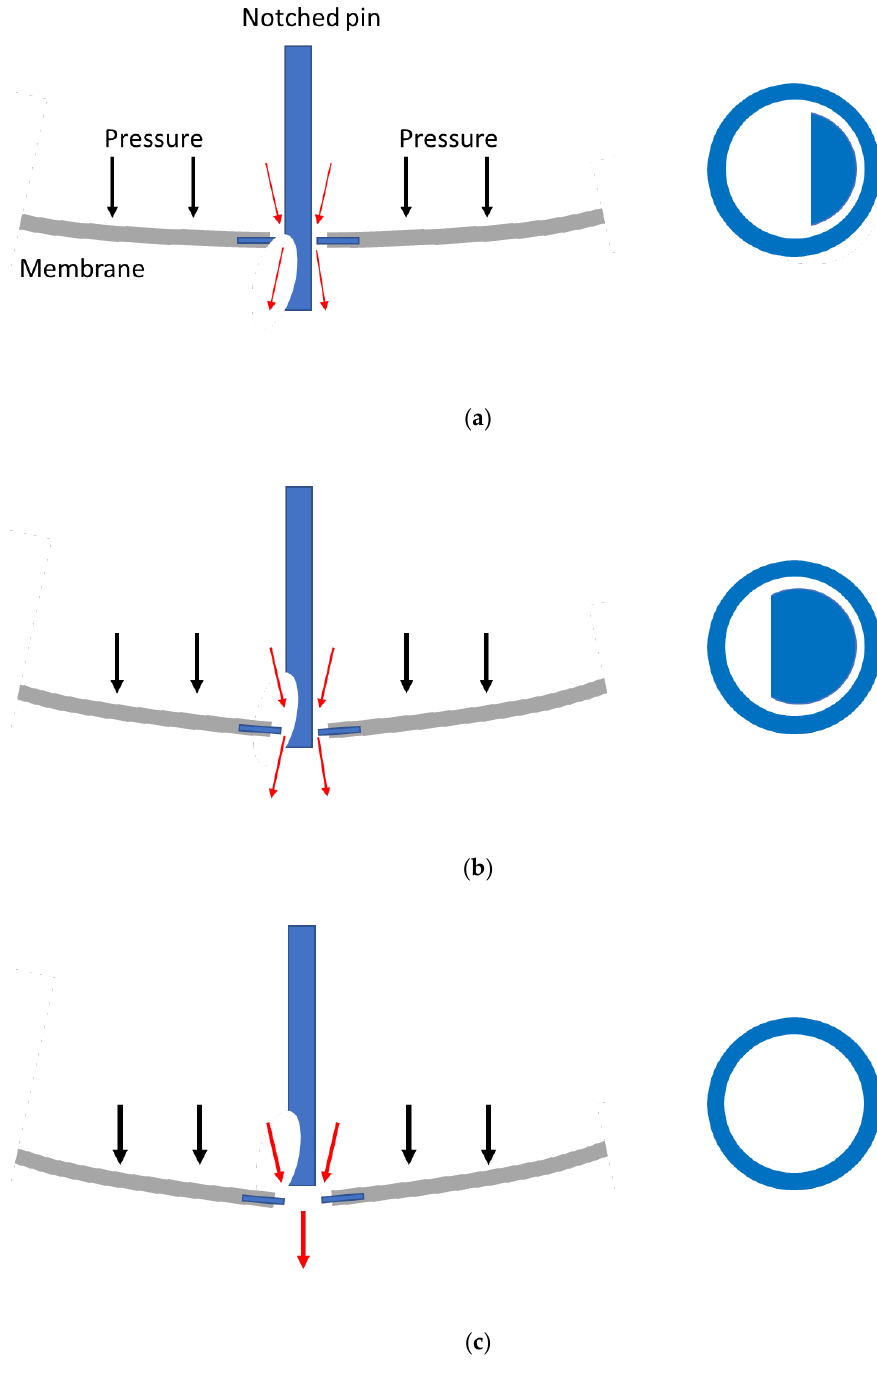
Figure 10. Schematic drawings of Orbis-Sigma II ® valve (left) and cross-section of the orifice between the membrane and the pin (right). The cerebrospinal fluid (CSF) flow is indicated by an arrow. ( a ) Differential pressure stage, with a low hydraulic resistance up to 9 mbar . ( b ) Flow regulating stage, with a progressive narrowing of the orifice as the pressure increases from 9 to 36 mbar. ( c ) Safety stage beyond 36 mbar, with a low hydraulic resistance to restore normal ICP.